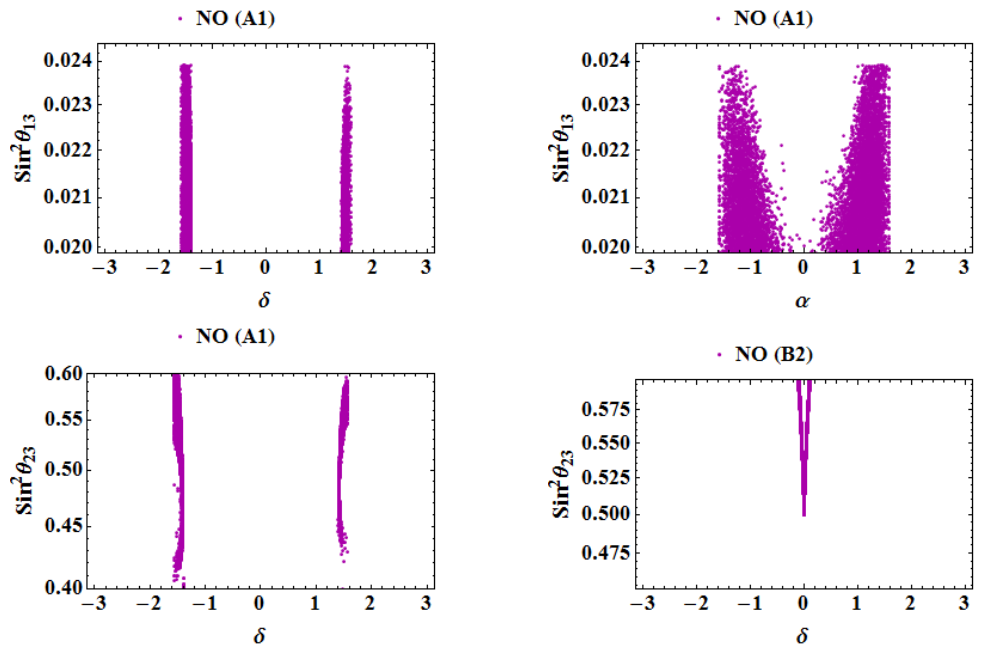
Figure 7 . Correlation between neutrino parameters in NO case.